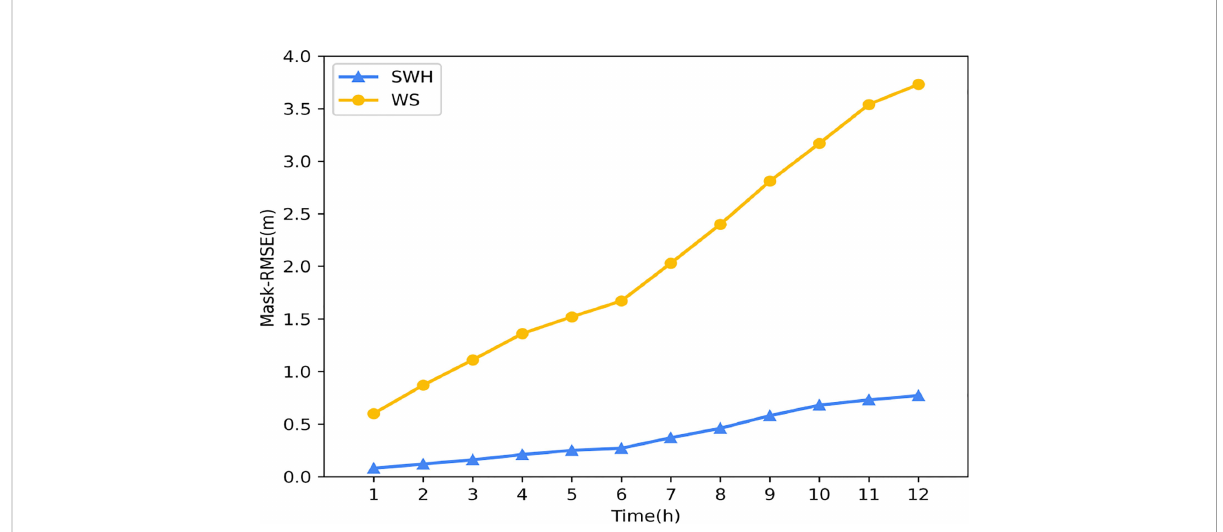
FIGURE 11 The Mask-RMSE of signi fi cant wave height and wind speed changes with increasing forecast time.